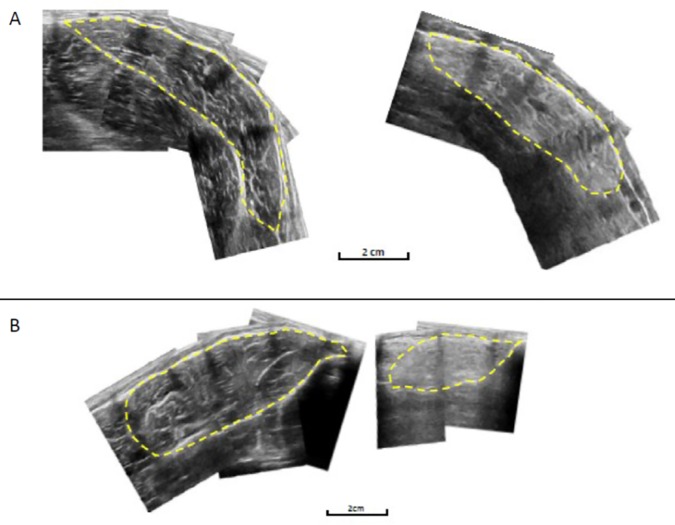
Example of the reconstruction of the GM (A) and TA (B) for Control (Left) and BeMD (Right) participants.